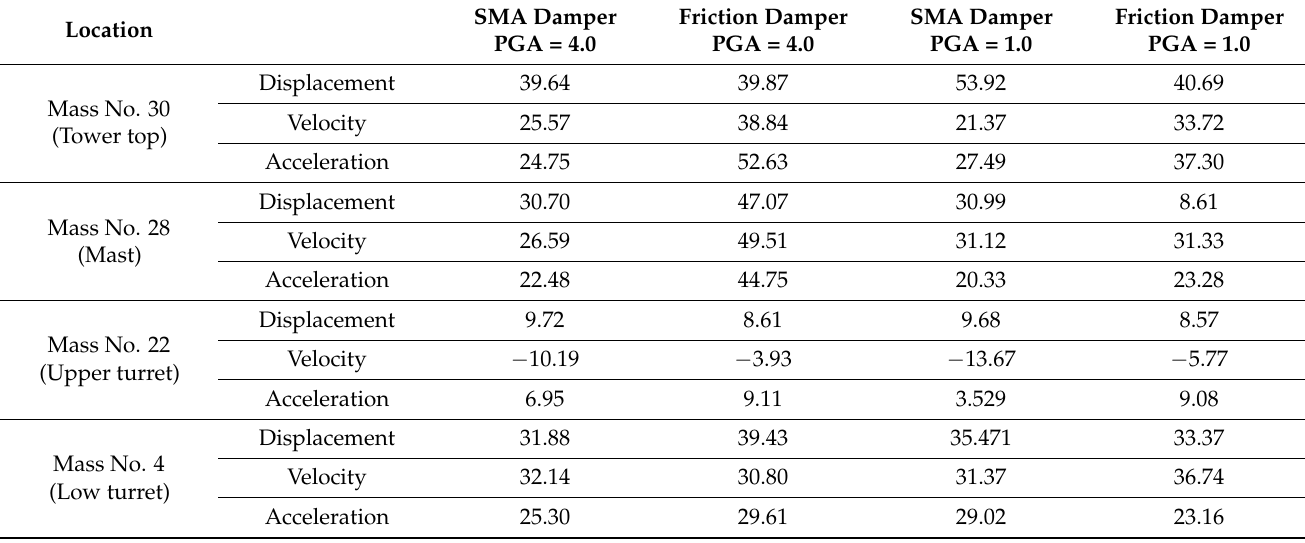
Table 5. Comparison of VRFs with different control approaches under different earthquake intensities.